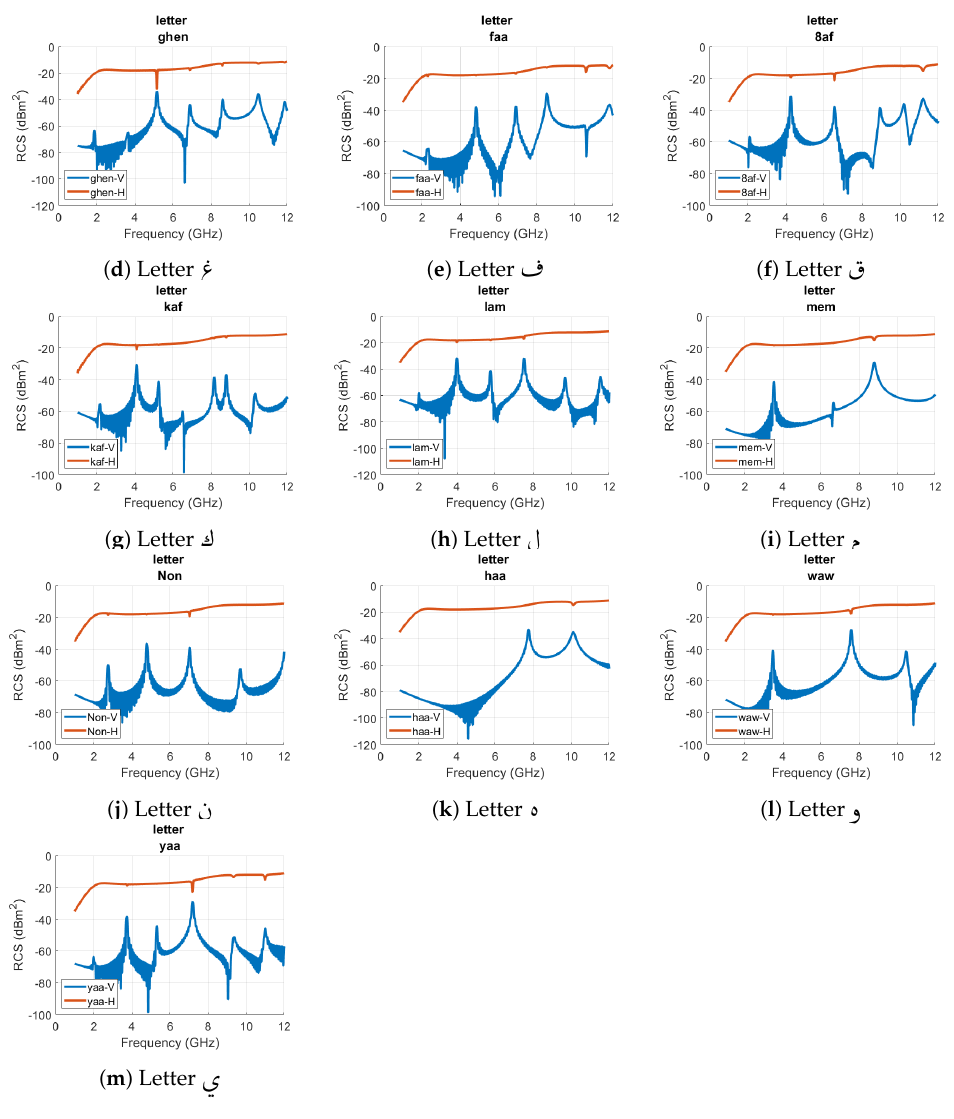
(cid:9) (cid:9) (cid:16) ) with Arial font type ¤ , ‹ , (cid:134) , … , ¨ , — , (cid:9) (cid:224) , Ł , (cid:240) , ł (cid:9) (cid:9) (cid:16) (cid:9) (cid:10) ) with Arial font type (cid:168) , (cid:172) , (cid:224) , (cid:232) , (cid:240) , (cid:248) (cid:134) , (cid:188) , (cid:200) , (cid:208) , (cid:10)